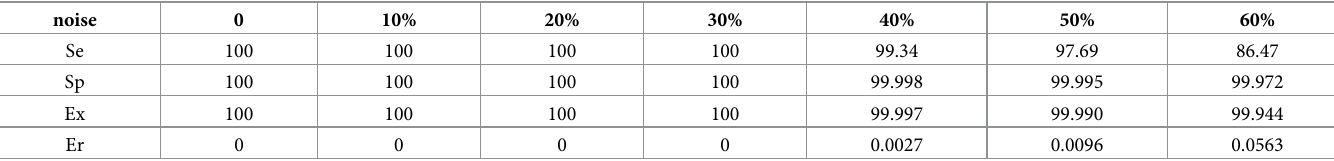
Table 3. Quadruple evaluating metrics for different mutation rates (%)– 3 × 3 coding set. noise